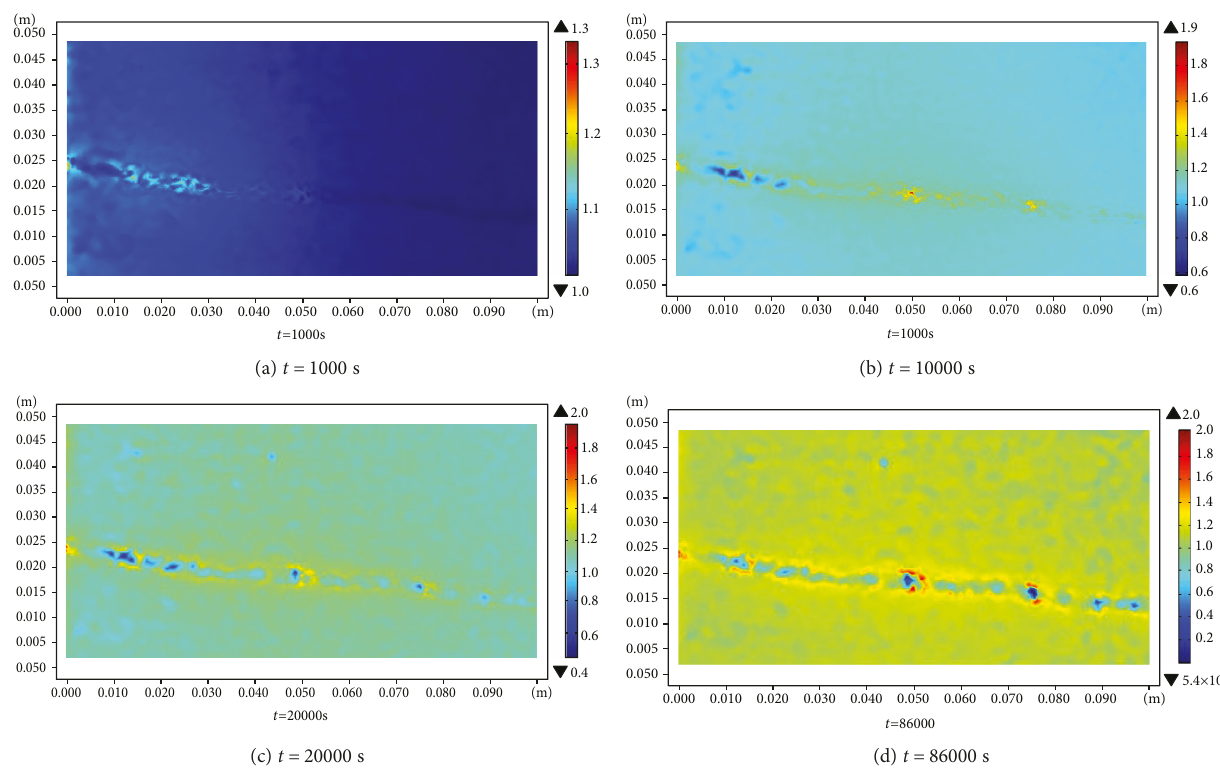
Figure 12: The evolution of the permeability ratio k / k